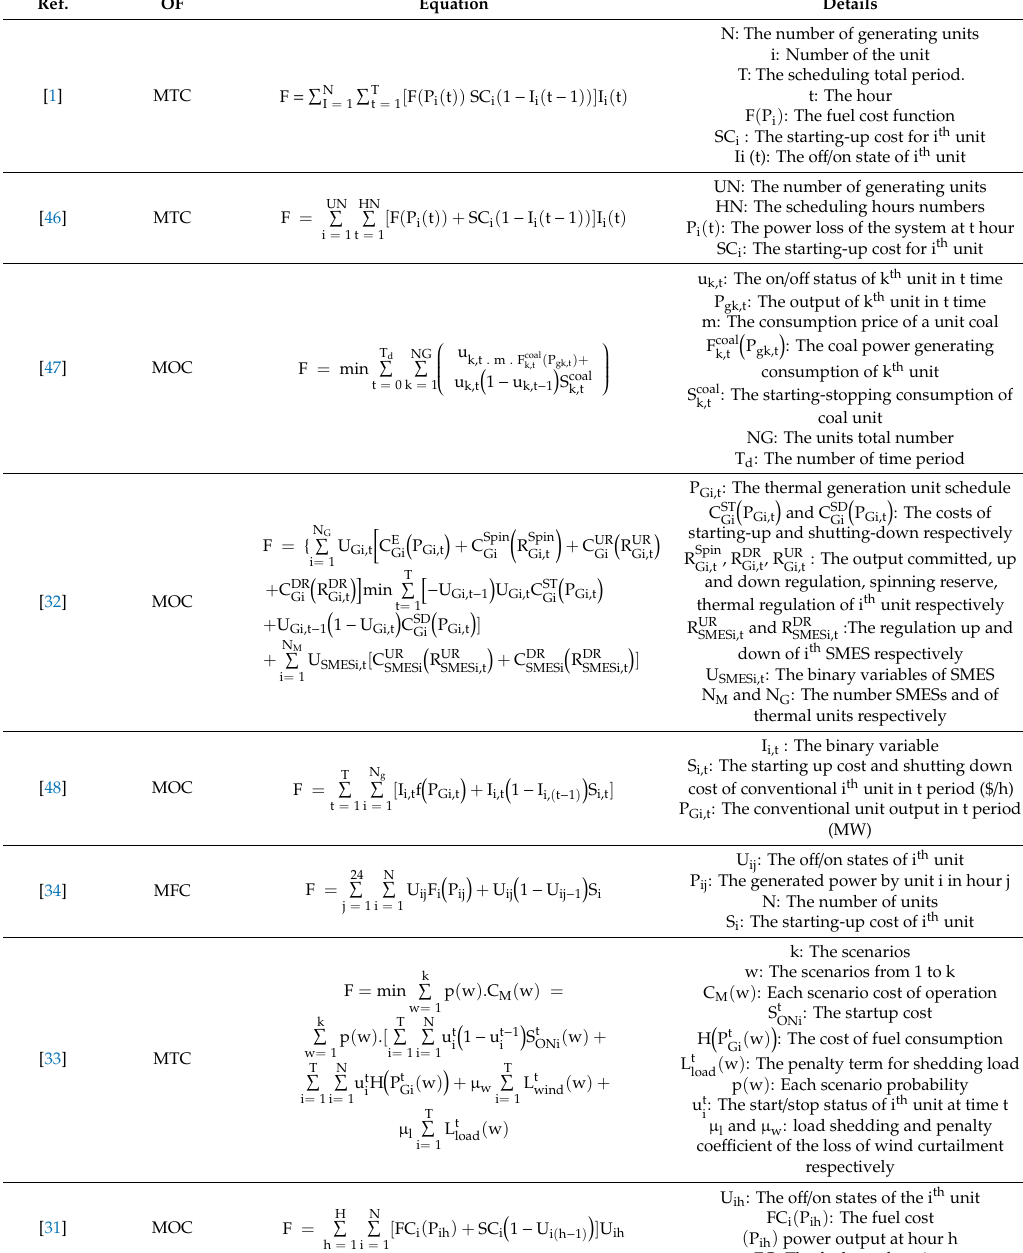
Table 4. Objective functions for the studies that utilize other method with particle swarm optimization.